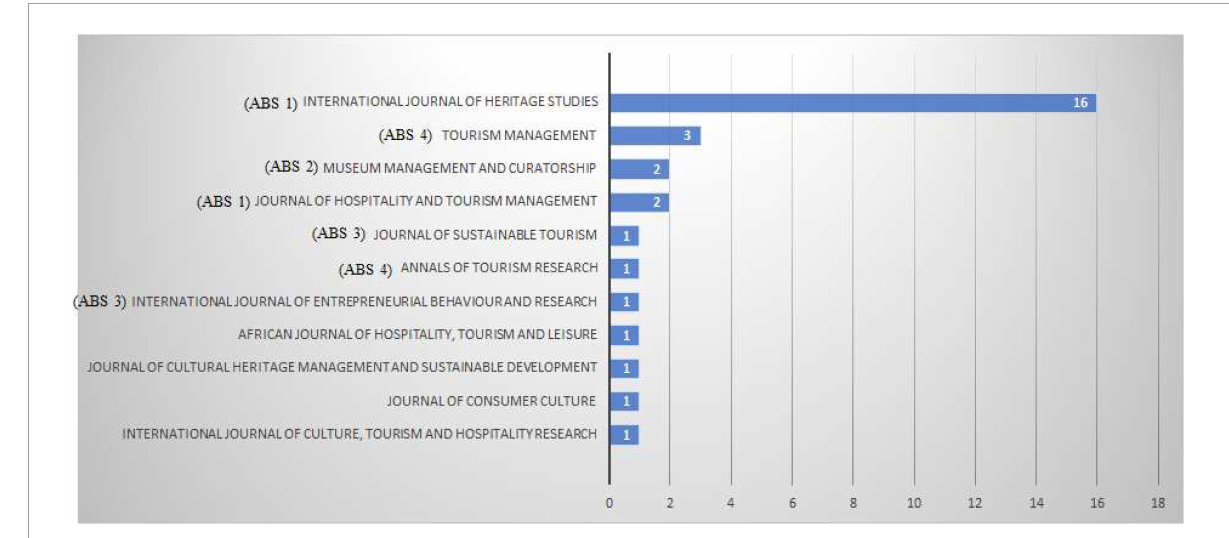
FIGURE2 Number of articles per